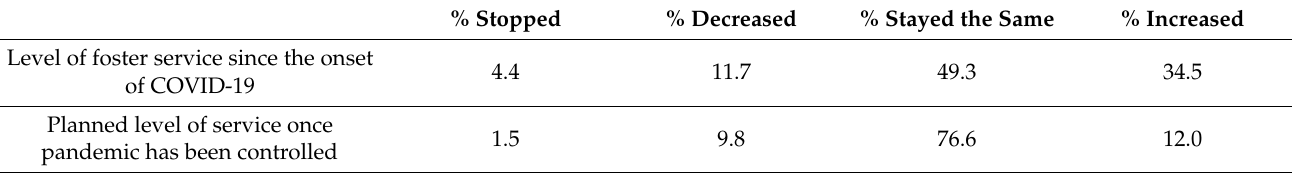
Table 5. Fostering during the pandemic and planned